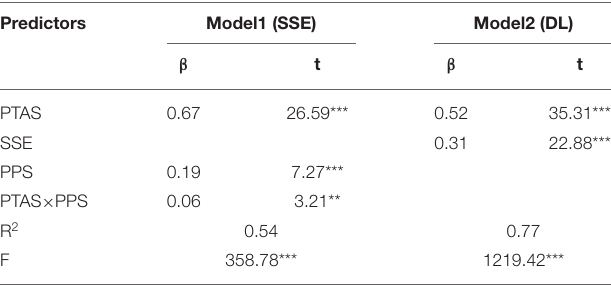
TABLE 3 | Testing the moderated mediation effect of perceived teacher autonomy support and student deep learning.